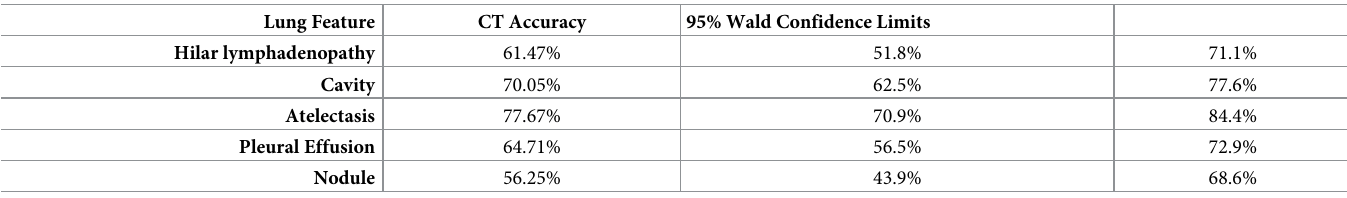
Table 9. 184 TBPP CT Annotations versus Qure.ai Continuous Score, Receiver Operating Characteristic Statistics